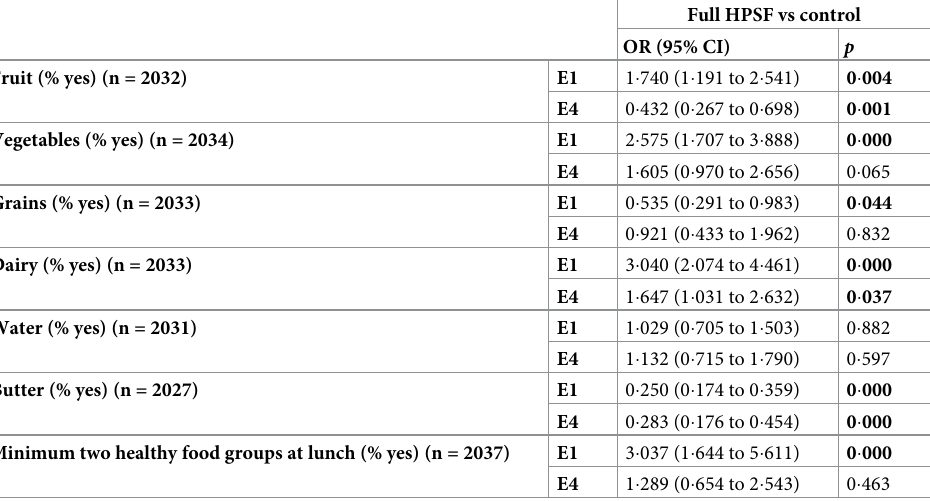
Table 4. Estimated intervention effects at E1 and E4 on lunch